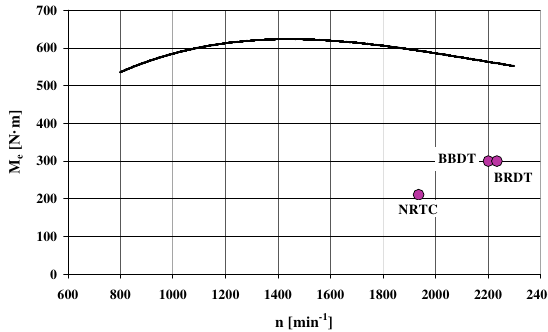
Fig. 12. Courses of the hydrocarbons emission intensity – E HC in tests Fig. 10. Points of coordinates: the average value of the engine speed – n, the average value of the engine torque – M e in tests against the background of full-load torque vs. speed curve